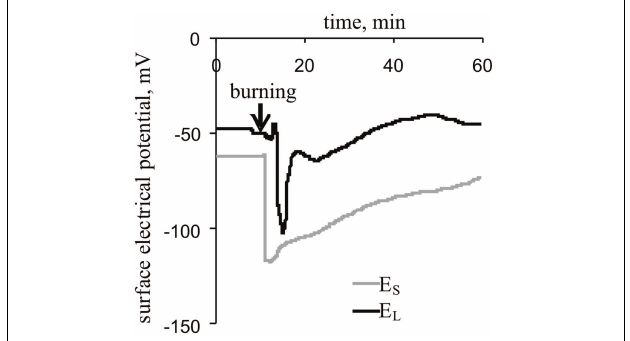
FIGURE 2 | Changes in the surface electrical potential of the stem near the second leaf (E S ) and at the center of its leaflet (E L ), as induced by the burning of the first leaf ( n =